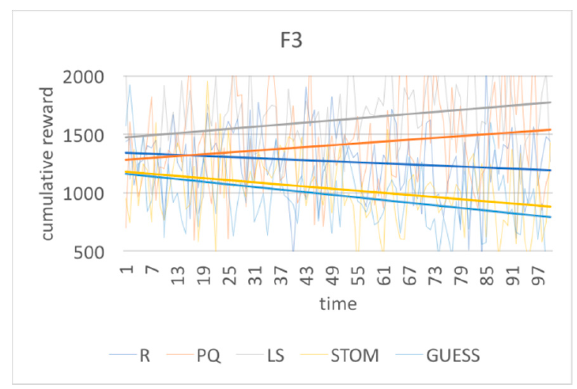
Figure 4. Cumulative reward over time for f (2) .